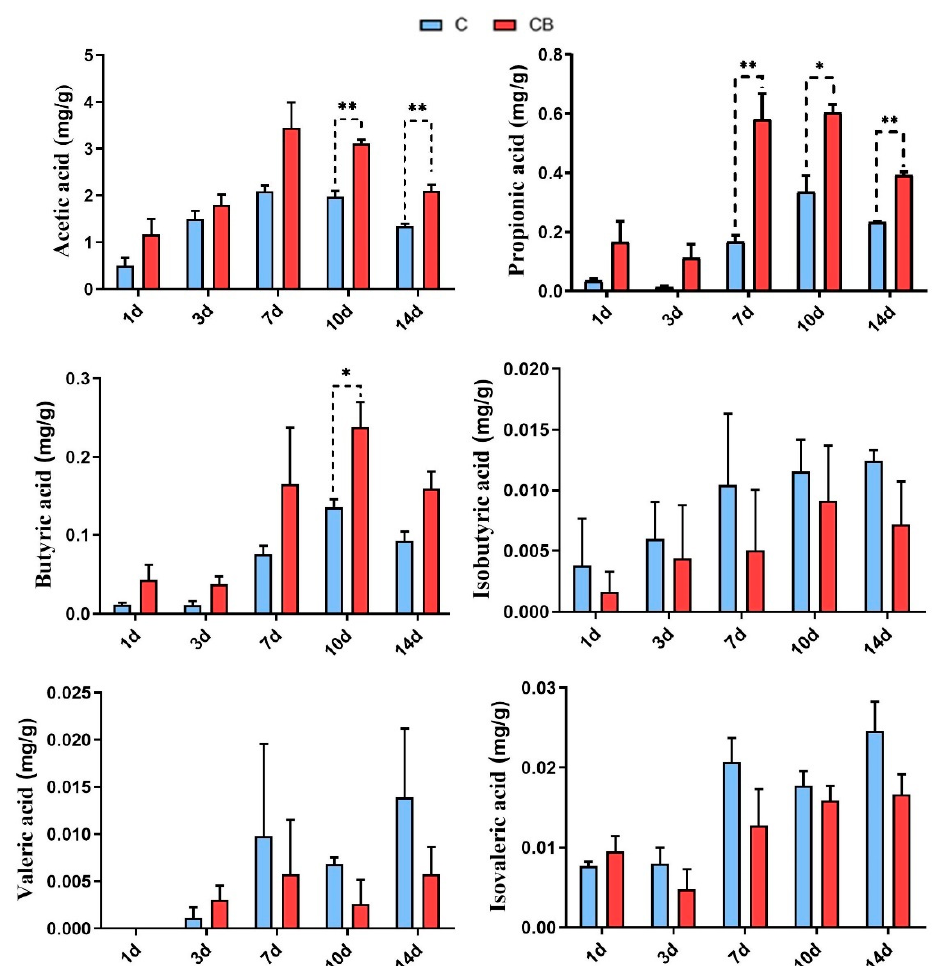
Figure 8. The concentrations of short-chain fatty acids (SCFAs) in the cecum of the Muscovy ducks in the C group and the CB group. Data were expressed as the mean ± SD ( n = 8). Differences between the C and CB groups at each time point were analyzed by the unpaired two-tailed Student’s t -test. * p < 0.05, ** p < 0.01. C group, control group; CB group, C. butyricum group. 1d, 3d, 7d, 10d, and 14d represent 1st day, 3rd day, 7th day, 10th day, and 14th day of the present experiment, respectively.